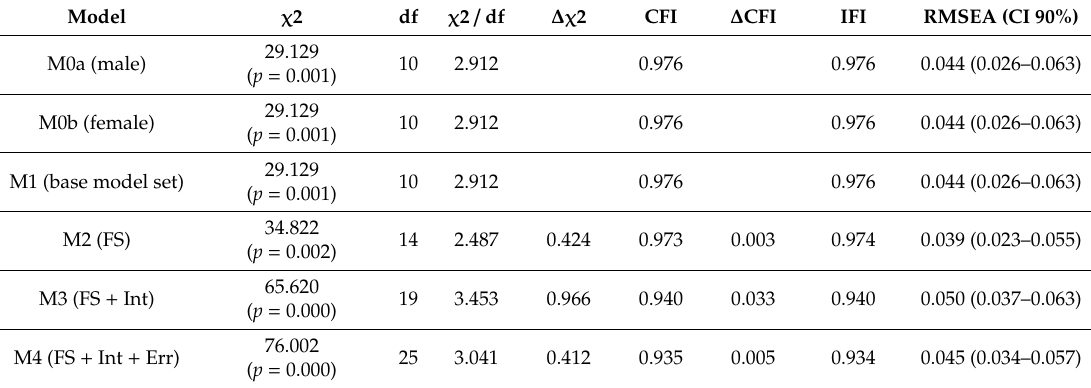
Table 4. Multigroup invariance by sex (male /